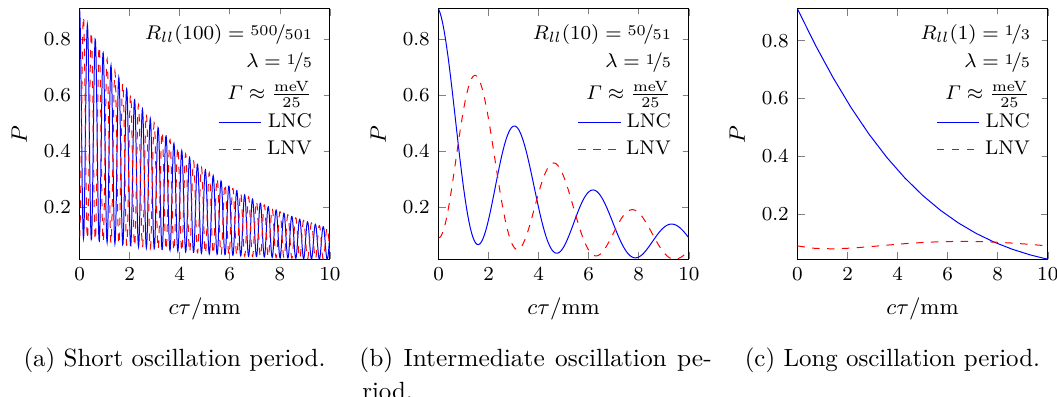
Figure 4 . Oscillations of the probability P that the process shown in figure 3 is LNC or LNV as a function of the proper time τ . The oscillation period depends on the mass splitting ∆ m , the overall decay depends on the decay width Γ , and the decoherence depends on the damping parameter λ , all of which are defined in section 3 . 2 . Panel (a) shows a short oscillation period with ∆ m/ Γ = 100 , panel (b) shows an intermediate oscillation period with ∆ m/ Γ = 10 , and panel (c) shows a long oscillation period with ∆ m/ Γ = 1 . All oscillations are shown for Γ defined in section 3 . 3